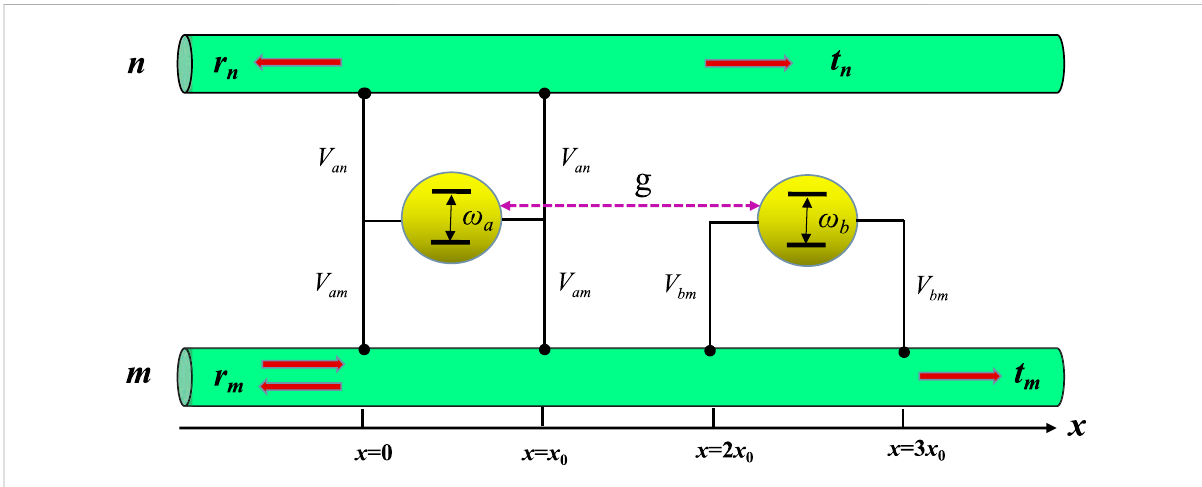
FIGURE 1 Schematic con fi guration of routing single photons in two channels made of two in fi nite linear waveguides. The giant two-level atom a couples twice with the waveguide m (waveguide n )at x = 0 and x = x 0 with strength V am ( V an ), and the giant two-level atom b only interactsthe waveguide m at x = 2 x 0 and x = 3 x 0 with strength V bm . The purple dashed line indicates an interatomic interaction with strength g. Initially, a single photon is launched from the left side of waveguide m and then is re fl ected, transmitted, or transferred to waveguide n